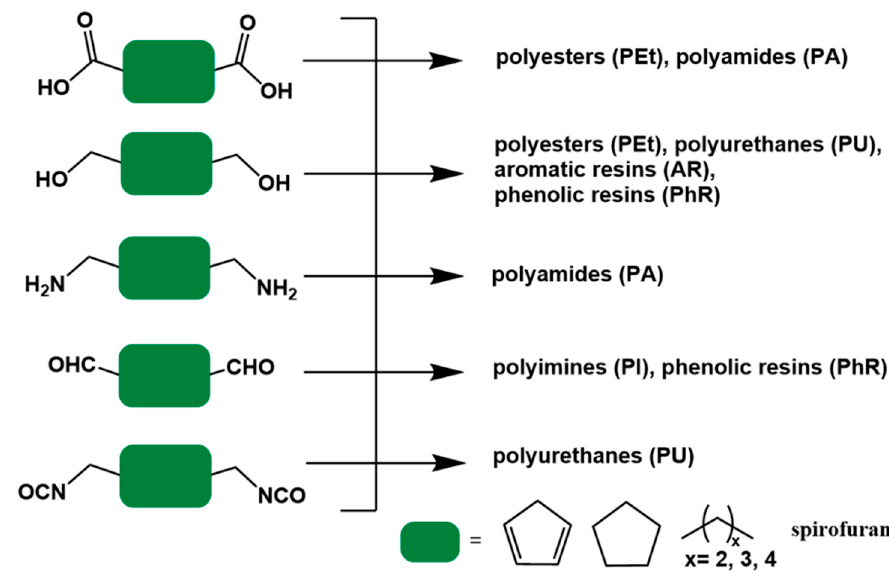
Figure 7. 5-HMF-derived bio-based monomers for polymer species. (The green block is used for structure